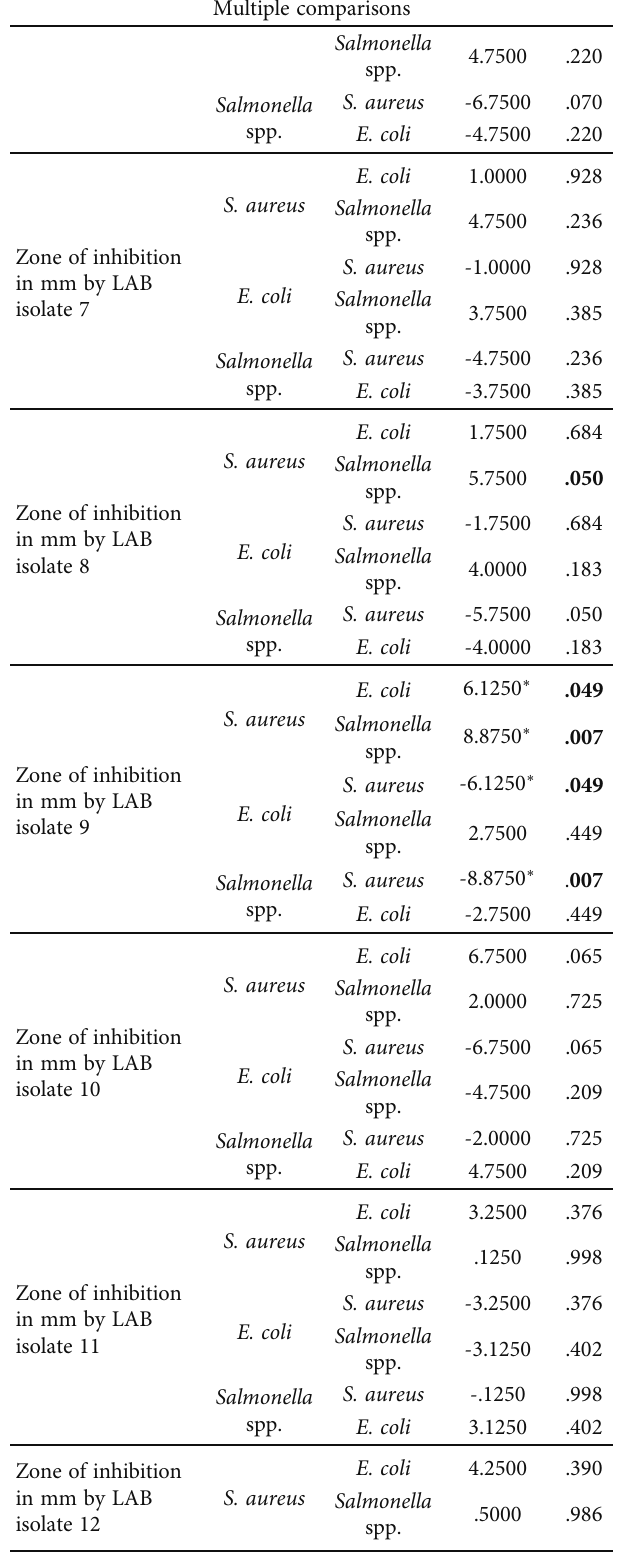
Table 5: Multiple comparison of average inhibition zone of LAB isolated from Ergo samples, Jimma town, southwest